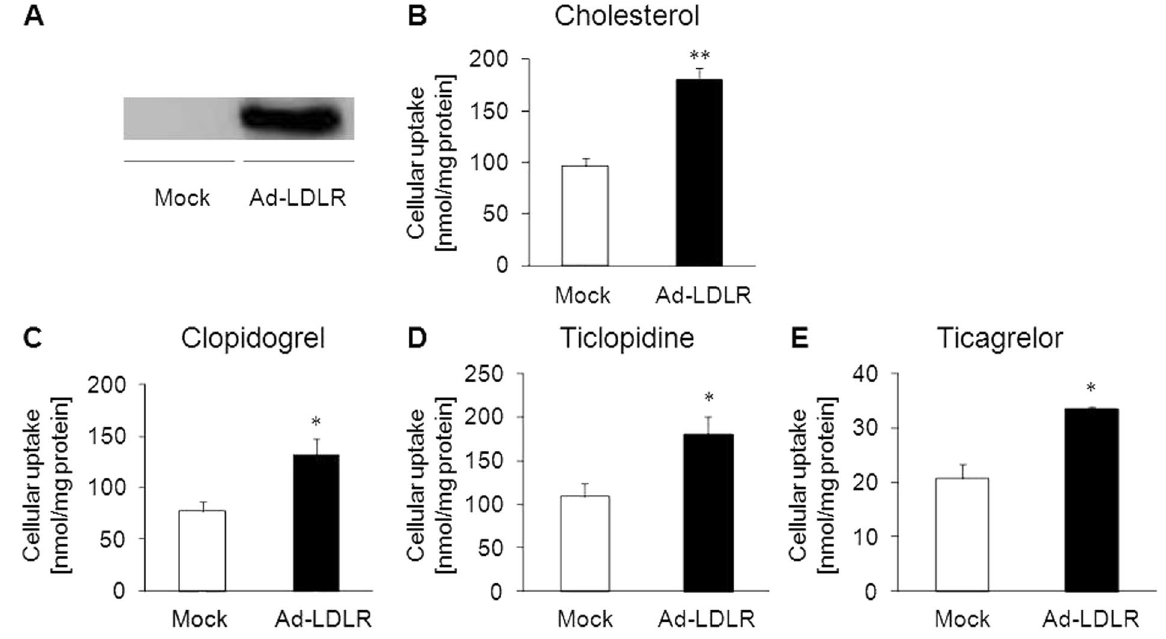
Figure 3. Effect of LDLR overexpression on LDL-mediated drug transport in vitro . ( A ) Hepa1-6 cells were infected with green fluorescent protein (GFP)-tagged mouse LDLR-expressing adenovirus (Ad-LDLR). Two days after infection, LDLR-GFP overexpression was confirmed by western blotting. GFP-expressing adenovirus (Mock) was used as a control. (B) The uptake of LDL solution containing [ 3 H]cholesterol in FBS-free transport buffer was measured in Mock and Ad-LDLR cells. (C–E) In vitro uptake experiments for LDL-associated (C ) clopidogrel, ( D ) ticlopidine, and ( E ) ticagrelor in Mock and Ad-LDLR cells. Bars represent the mean ± s.e.m. * p < 0.05, ** p < 0.01.